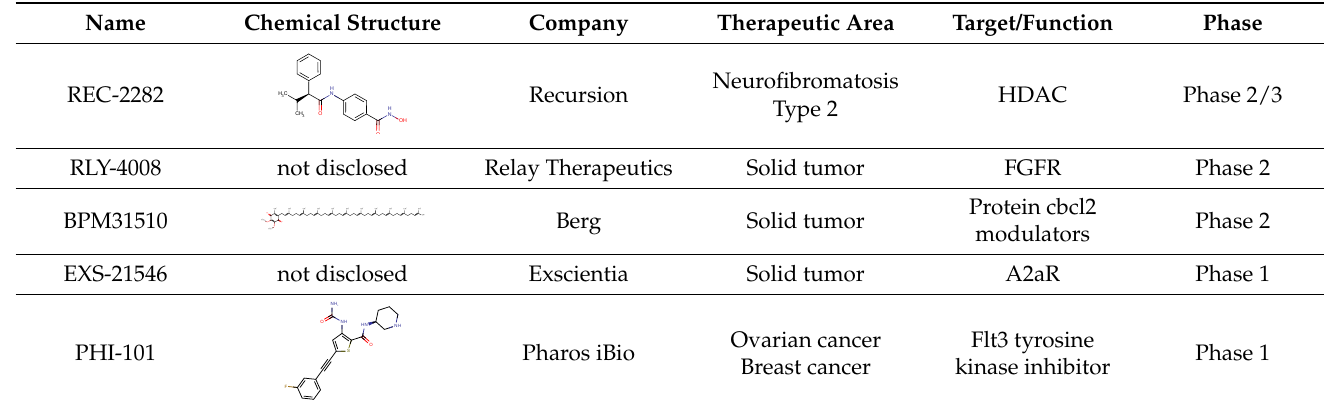
Table 8. Some of the AI-designed anti-cancer drugs that have successfully entered human phase 2/3 clinical trials in the last 5 years.